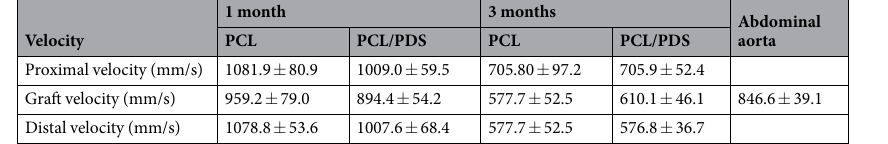
migration to some extent.